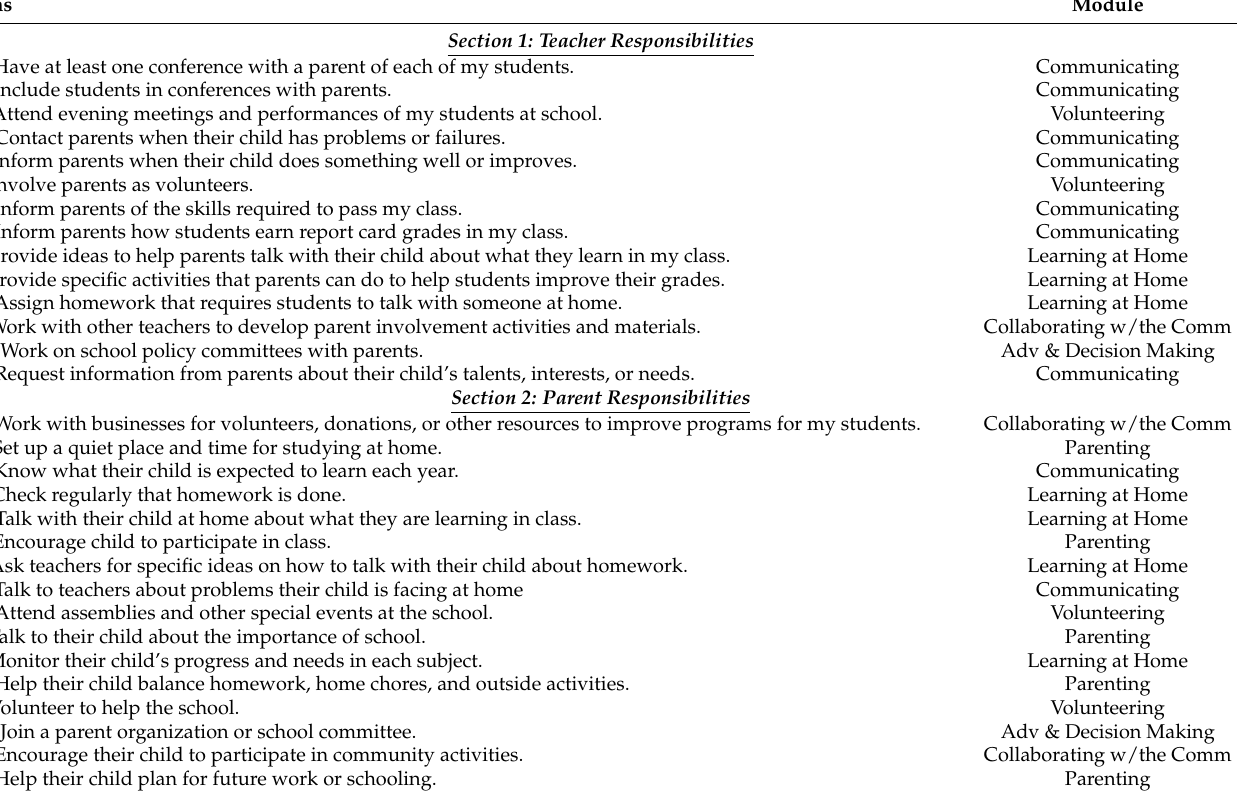
Table 1. Attitude towards parent involvement items and corresponding PTE Connection